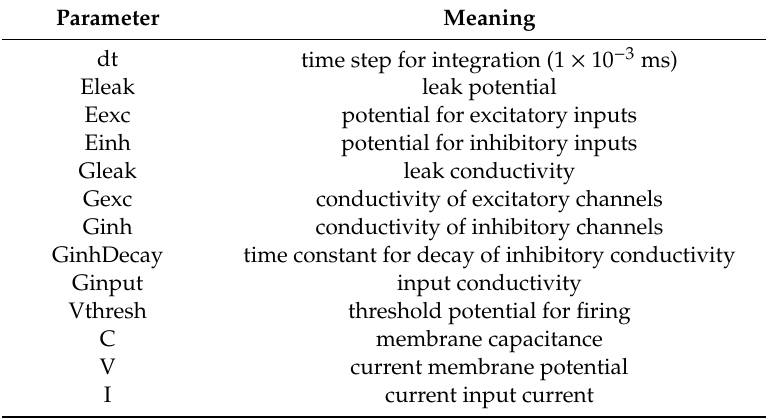
Table 1. LIF parameters of the Saliency Model [5]. For more details about the specific implementation, see [18] and the Matlab SaliencyToolbox